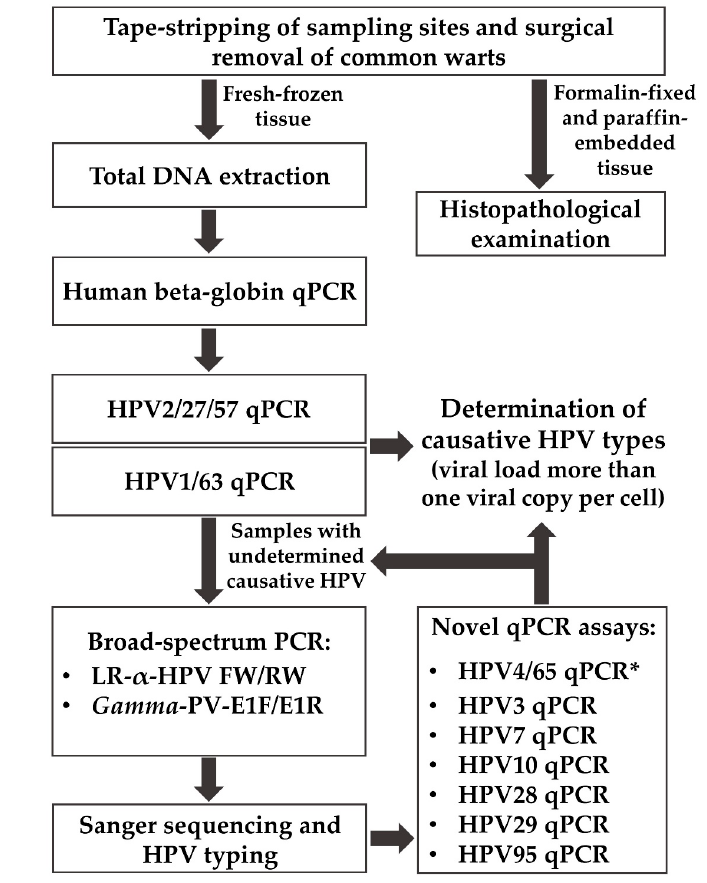
Figure 1. Protocol for the comprehensive characterization of causative human papillomavirus (HPV) types in fresh-frozen tissue samples of histologically confirmed common warts.